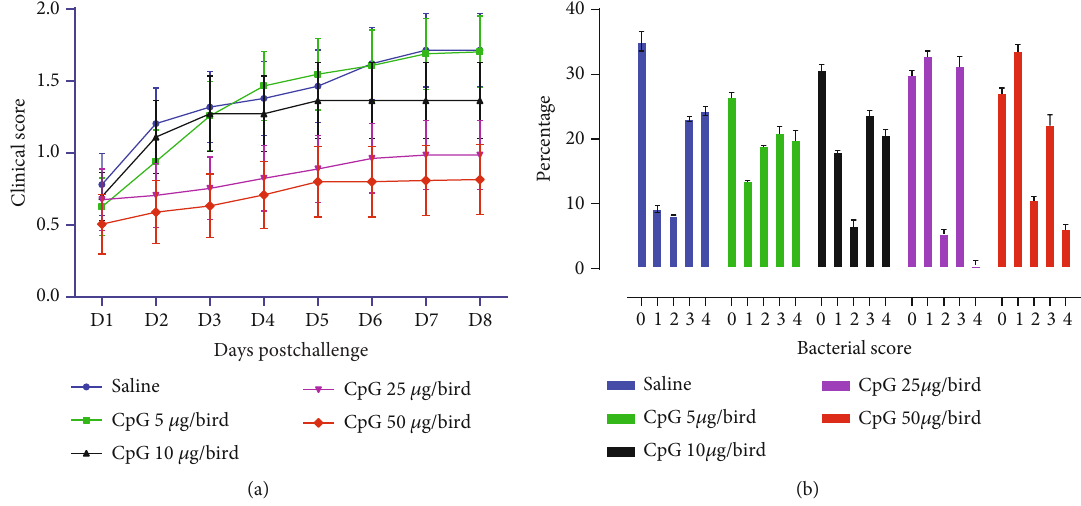
Figure 6: Clinical scores and bacterial growth following the E. coli challenge. (a) Clinical scores (CCS) of broiler chickens following E. coli challenge. Each data point represents the CCS of the individual group at that point (bar =mean with SEM). A signi fi cantly less CCS was recorded in 25 μ g ( P = 0 : 0025 ), and 50 μ g ( P = 0 : 0016 ) of CpG-ODN treated groups, compared to the saline-treated group. (b) Bar graph shows the percentage of birds in each treatment group that had each classi fi cation of bacterial growth. Bacterial swabs were taken from air sacs. Groups that received 25 μ g and 50 μ g of CpG-ODN showed signi fi cantly ( P < 0 : 0001 ) less number of birds with higher levels (4+) of bacterial growth compared to other